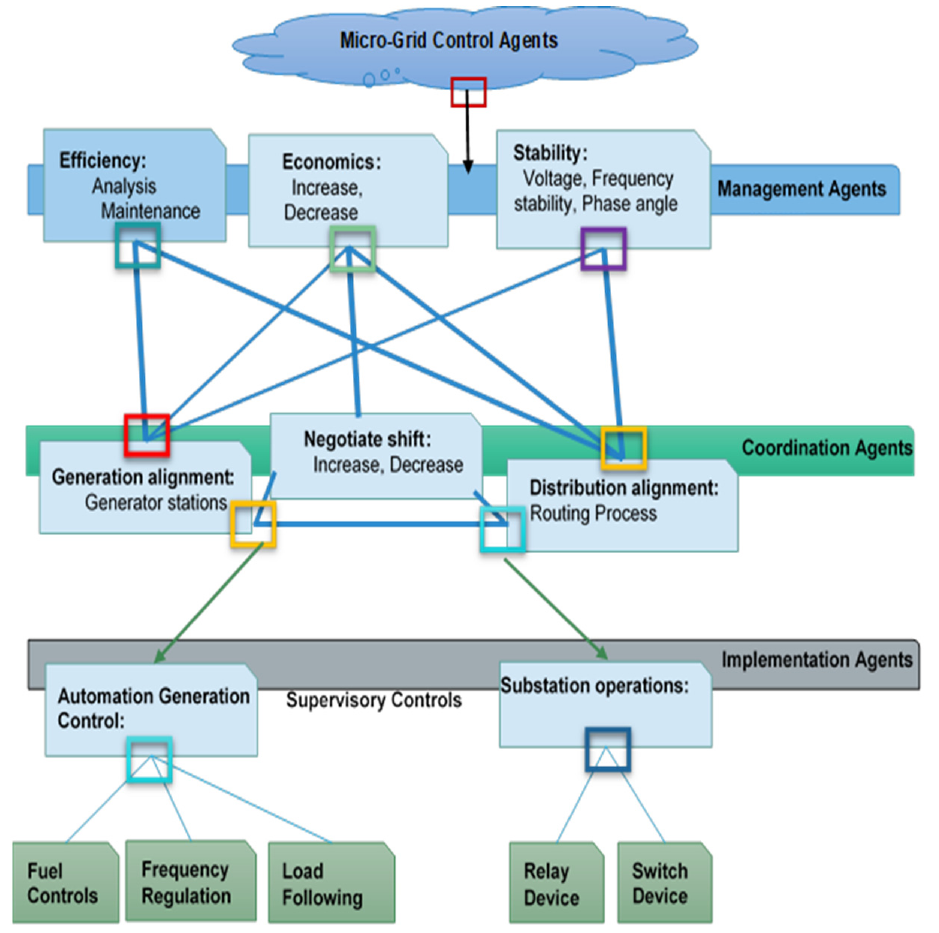
Figure 7. Microgrid Control Agents.